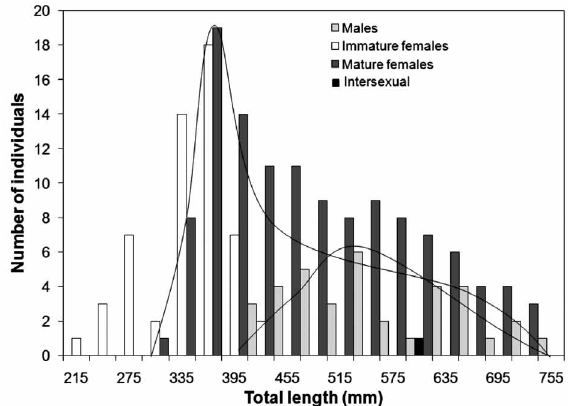
Fig . 1. – Size-frequency distribution in number of fish for males and females of Mycteroperca fusca caught between January 2004 and December 2005 in waters of the Canary Islands.